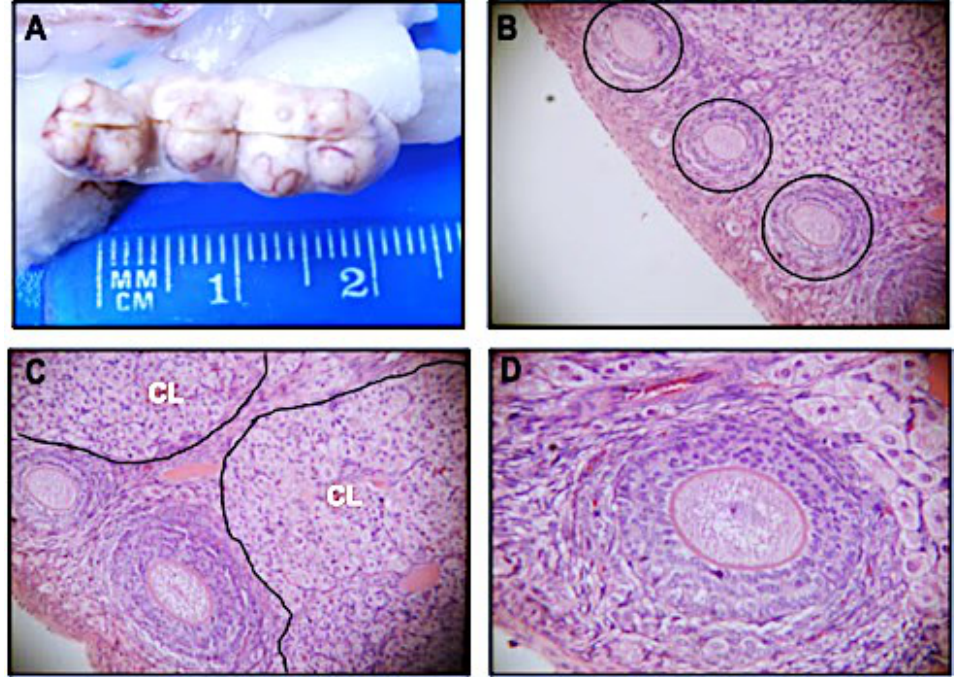
Figure 1. Normal macroscopic and microscopic views of an ovary from an Sm14/GLA-SE-vaccinated pregnant rabbit. Panel ( A ) depicts the normal macroscopic pattern of the ovary, showing a multinodular outer surface and brownish structure with marked vessels. Panel ( B ) shows a microscopic view of follicles in various stages of development in the cortical region (within the black circles). Corpora lutea (CL) can be seen in panel ( C ), whereas a higher magnification of a follicle can be seen in panel ( D ). Sections were stained with hematoxylin–eosin. Scale magnification with 40 × (in panel ( B )), 100 × (in panel ( C )), and 200 × (in panel ( D ))